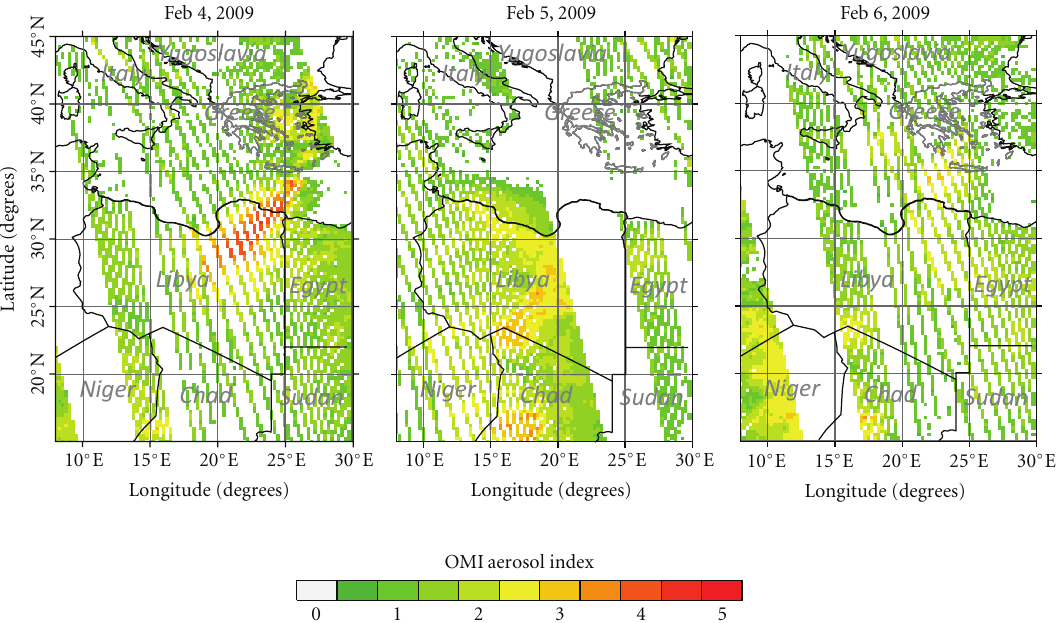
Figure 3: Spatial distribution of OMI-derived aerosol index (AI) over the study region during the period 4–6 February 2009.